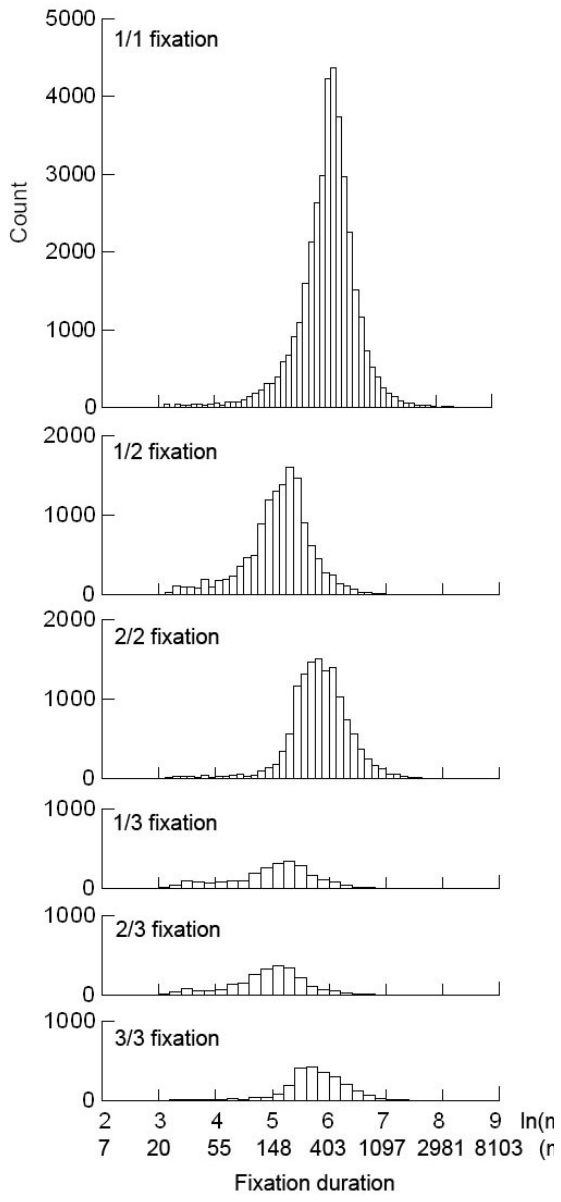
Figure 3. Fixation durations distributions in ln ms units plotted for six types of